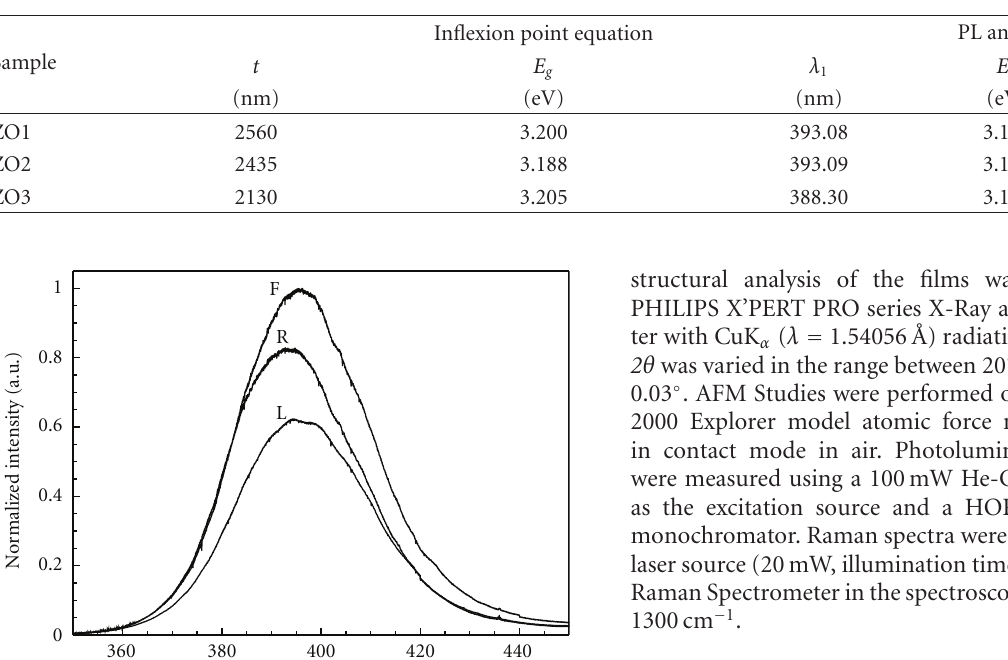
Table 1: Film thickness t (nm) and comparison of E g (eV) optical band gap values from inflexion point equation and photoluminescence (PL) analysis for ZnO thin films labelled as ZO1 for linear moved, ZO2 for fixed, and ZO3 for rotated substrate.